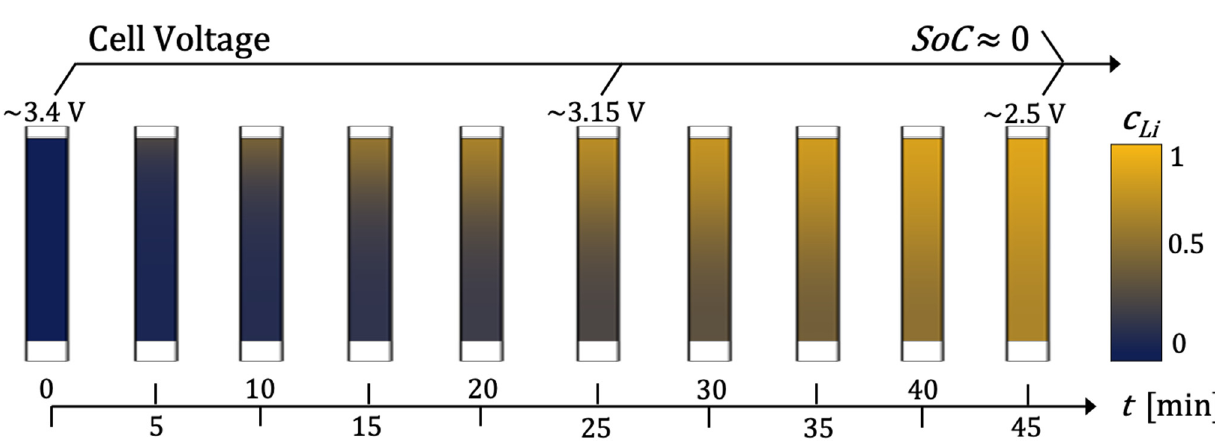
Figure A1. Time evolution of the normalised concentration of Li ions c Li (lithiation) within the single structure LFP electrode. The volume fraction is ε s = 0.4 with an electrode conductivity of σ LFP = 16 S m − 1 and a diffusion prefactor of D LFP = 1.18 × 10 − 18 at 1C discharge current and 298.15 K. The illustration of the cell (top—separator, bottom—current—collector) is not to scale.